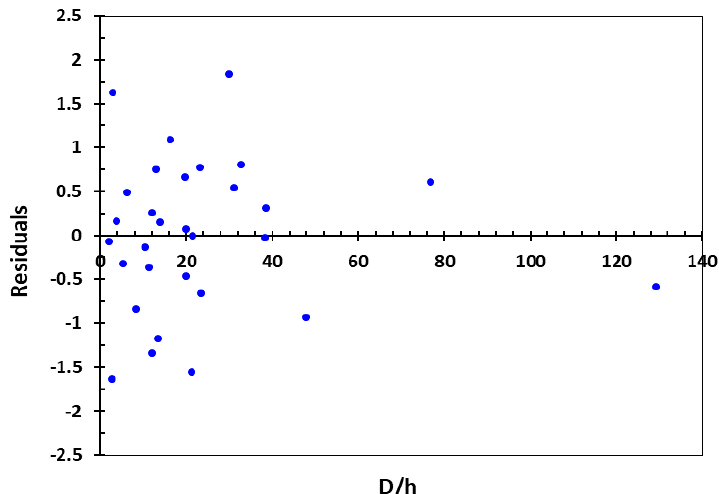
Figure 11. Residuals vs. gross to net thickness ratio for the database analyzed.